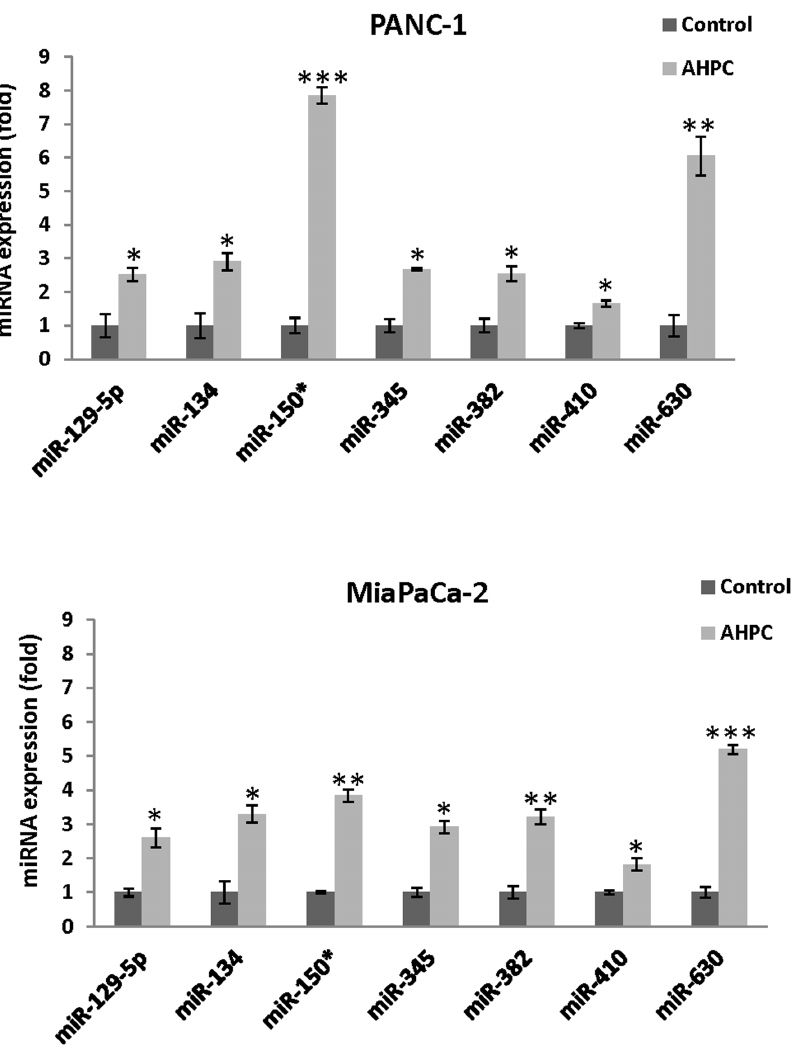
Figure 1. 3-Cl-AHPC mediated modulation of microRNAs in pancreatic cancer cells. MicroRNAs were validated by quantitative Real time PCR. Cells were treated with 3-Cl-AHPC for 24 h. Detail methodologies were as described in Materials and Methods. The error bars represent the mean of three separate determinations 6 the standard deviation (SD). *, ** and *** ( , 0.05, , 0.01 and , 0.001) were significantly different in comparison between control and treated samples using t -Test.